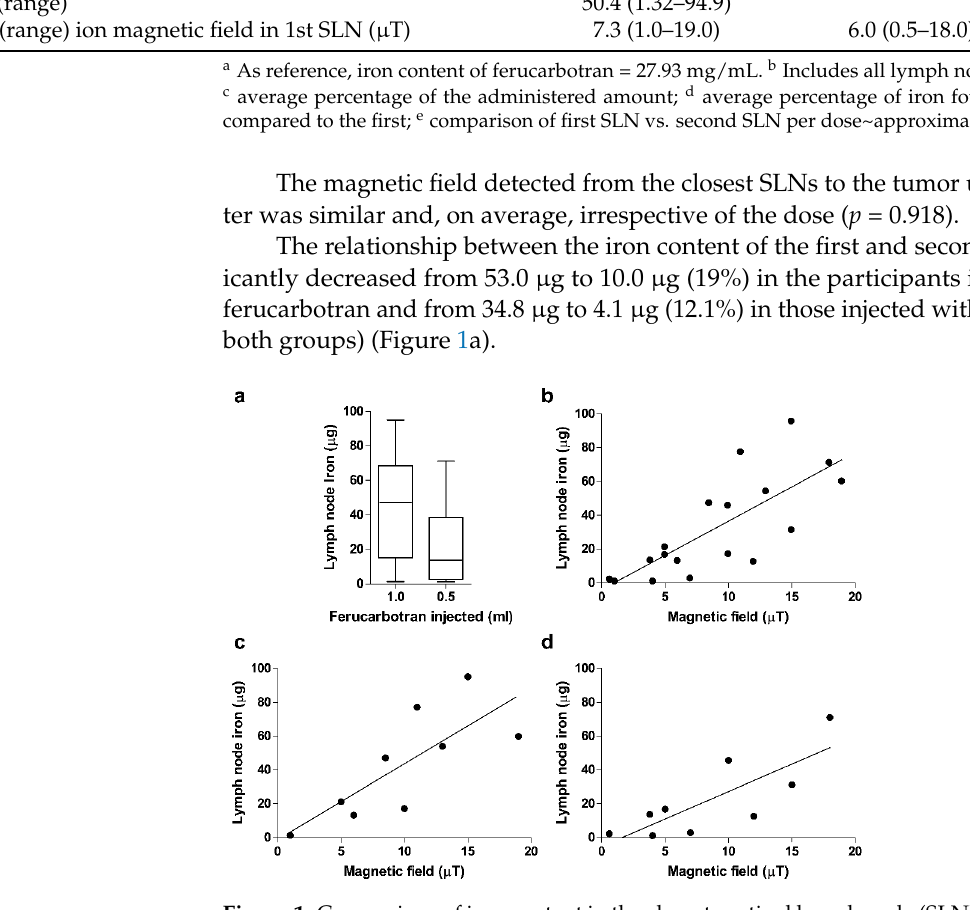
Figure 1. Comparison of iron content in the closest sentinel lymph node (SLN) to the tumor, accord- ing to injection volume. Biopsied SLNs had their magnetic field quantified using a magnetometer and their iron content quantified using the iron quantification device described in Kuwahata et al. [11]. ( a ). Boxplot of iron content of SLNs according to the volume of ferucarbotran injected. Pear- son’s test was used to compare patients who received 1.0 mL of ferucarbotran (average iron content 42.8 µg) vs. 0.5 mL (average iron content 21.9 µg) ( p = 0.131). ( b – d ) Correlation of magnetic fields recorded using the magnetometer vs. the iron content measured using the iron quantification de- vice. ( b ) Total participants and the correlation coefficient 0.57; p = 0.02. ( c ) Participants who received 1.0 mL of ferucarbotran and the correlation coefficient 0.59; p = 0.014. ( d ) Participants who received 0.5 mL of ferucarbotran and the correlation coefficient 0.63; p = 0.0102.